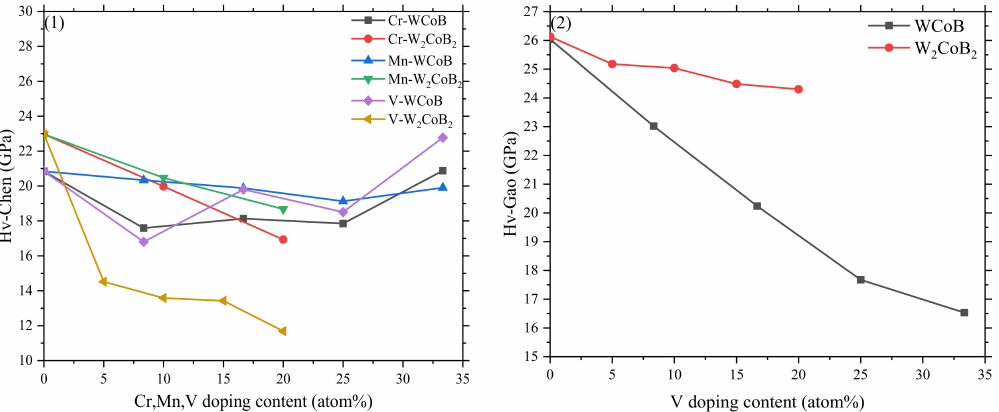
Figure 3. Plots of theoretical hardness versus V doping content of W 4 Co 4 − x (Cr, Mn, V) x B 4 and W 8 Co 4 − x V x B 8 ( x = 0, 1, 2, 3, 4), obtained by different models: ( 1 ) Hv-Chen; ( 2 )